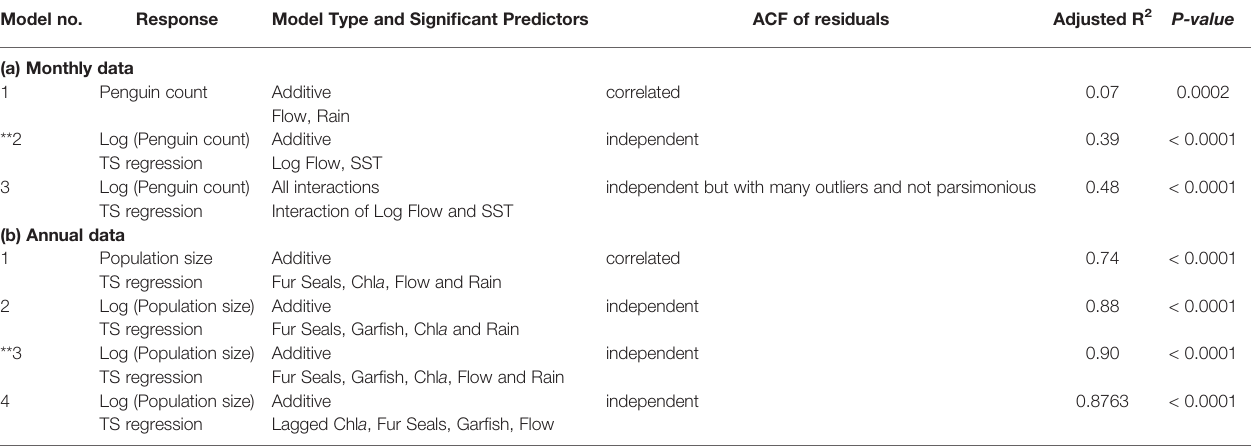
TABLE 1 | Best fi tted models examining the variation in (a) monthly and (b) annual little penguin numbers in relation to river out fl ow, sea surface temperatures, rainfall, chlorophyll- a concentrations (monthly and annual numbers), as well as long-nosed fur seal numbers and southern gar fi sh numbers (annual numbers only). Model